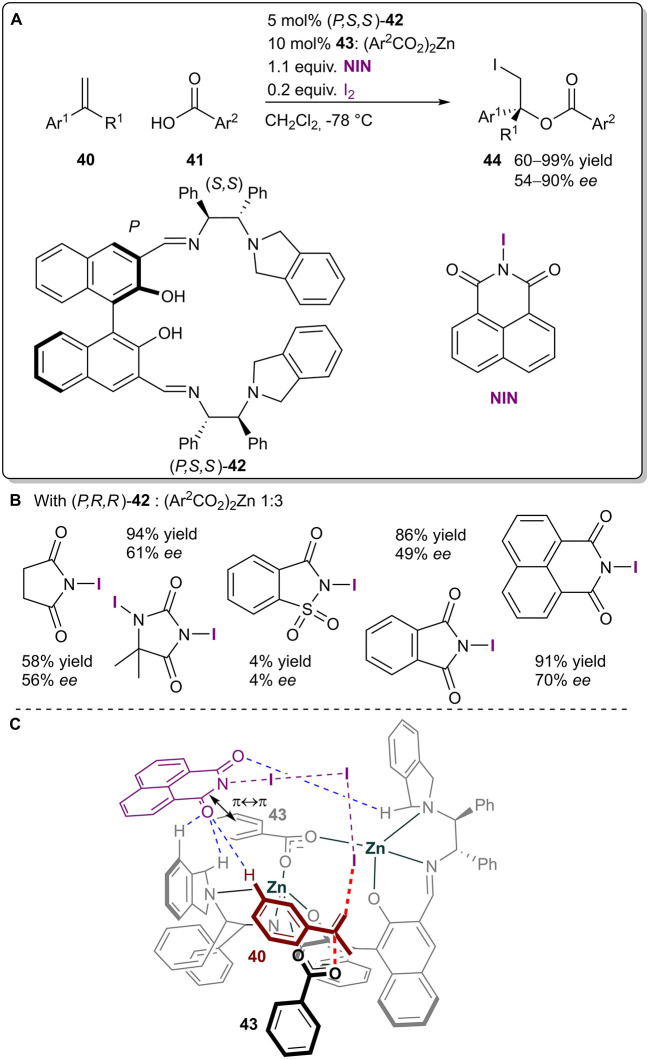
(A) Zinc-catalyzed asymmetric iodoesterification utilizing the I2-NIN complex as a halogenating agent; (B) comparison of the influence of the different halogen sources on the reaction; (C) proposed TS structure leading to the major product.